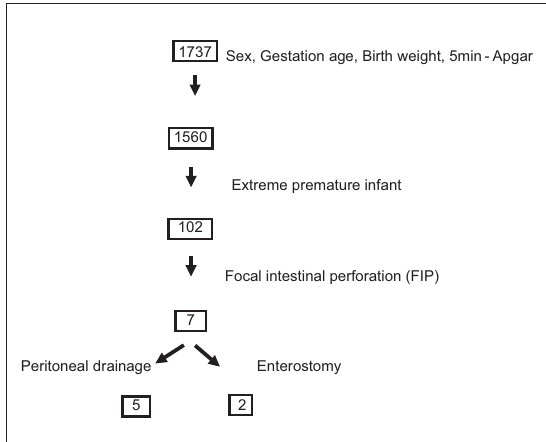
Fig ure 1: Study design (April 2007–March 2017) Table 1: Summary of extremely low birth weight infants who developed focal intestinal perforation M: